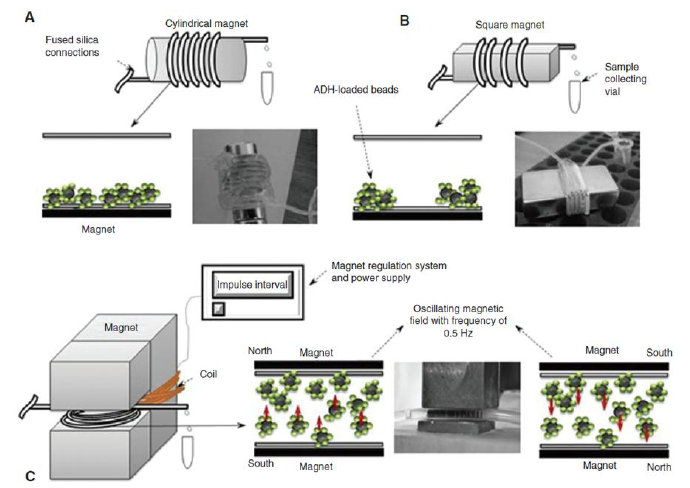
Figure 1. Different microreactor configurations ( A ) with a permanent cylindrical magnet, ( B ) with a permanent square magnet, and ( C ) with an oscillating magnetic field. Reproduced with permission from A. Šalić et al.; NAD + oxidation in a microreactor catalysed by ADH immobilized on γ-Fe 2 O 3 nanoparticles, published by De Gruyter, 2013.